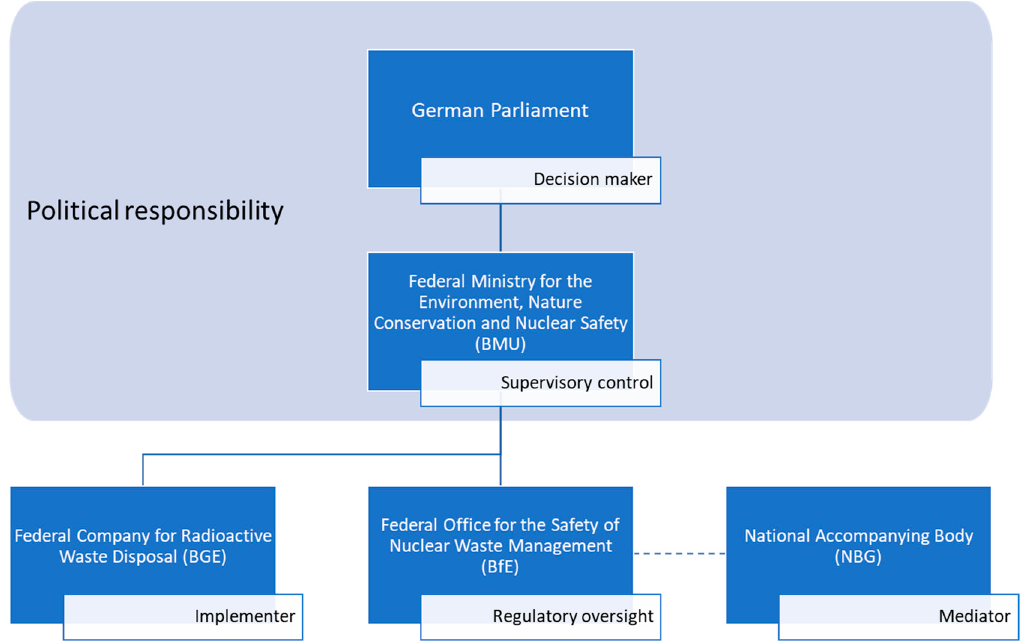
Figure 1. Roles of main actors in the site selection procedure.